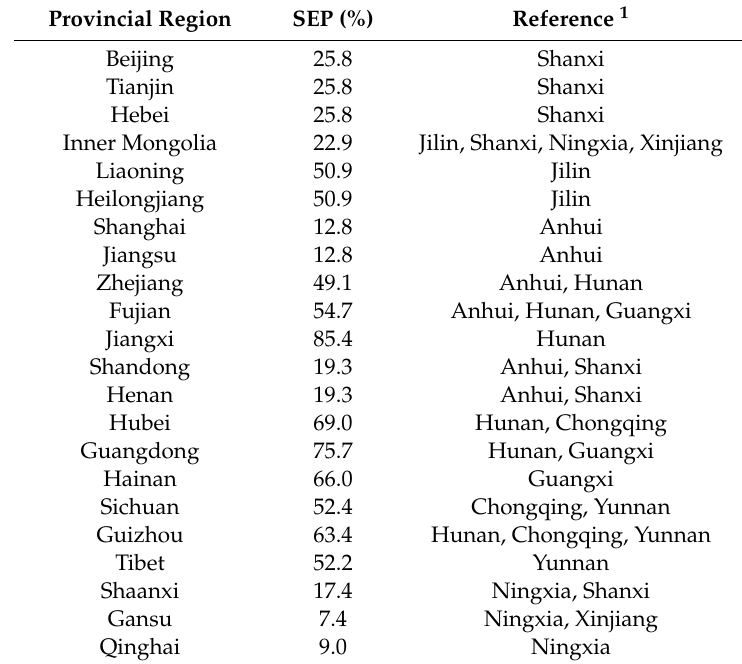
Table 2. Percentage of corn stover surplus for ethanol production (SEP) in non-sampled provincial regions referencing the neighboring provincial regions in